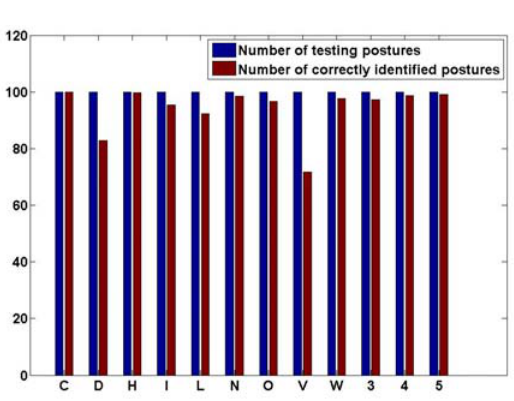
Figure 18. Recognition rates.